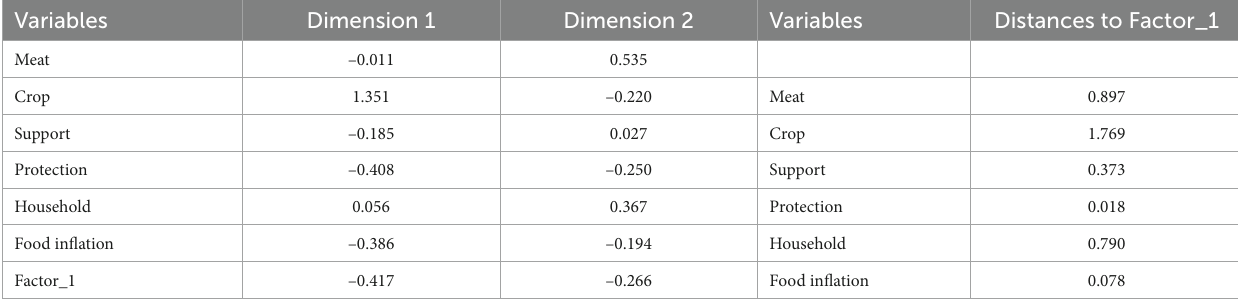
the vector (V), we multiplied the normalized values for each observation by the weights: